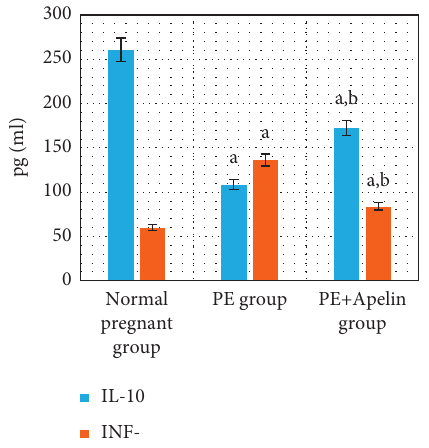
Figure 6: Serum IL-10 and IFN- c in all studied groups.